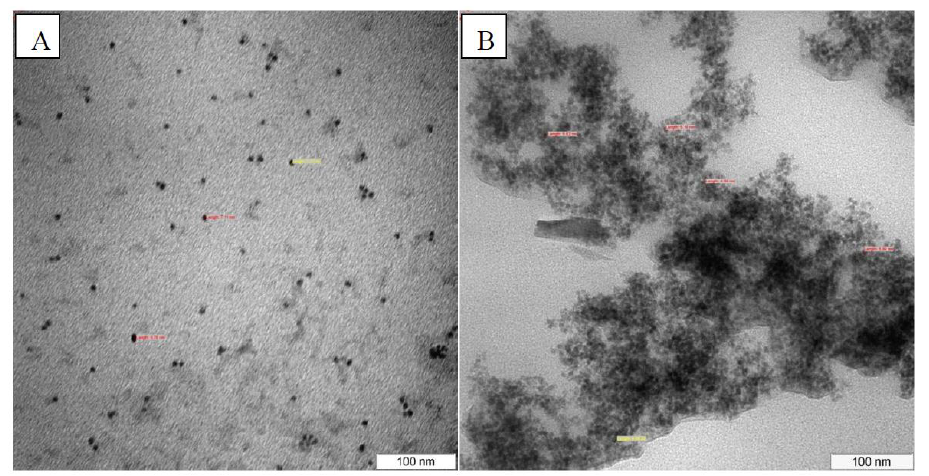
Figure 3. TEM image of ( A ) water soluble CdSe QD and ( B ) CdSe QD-ssDNA conjugate with magnification of